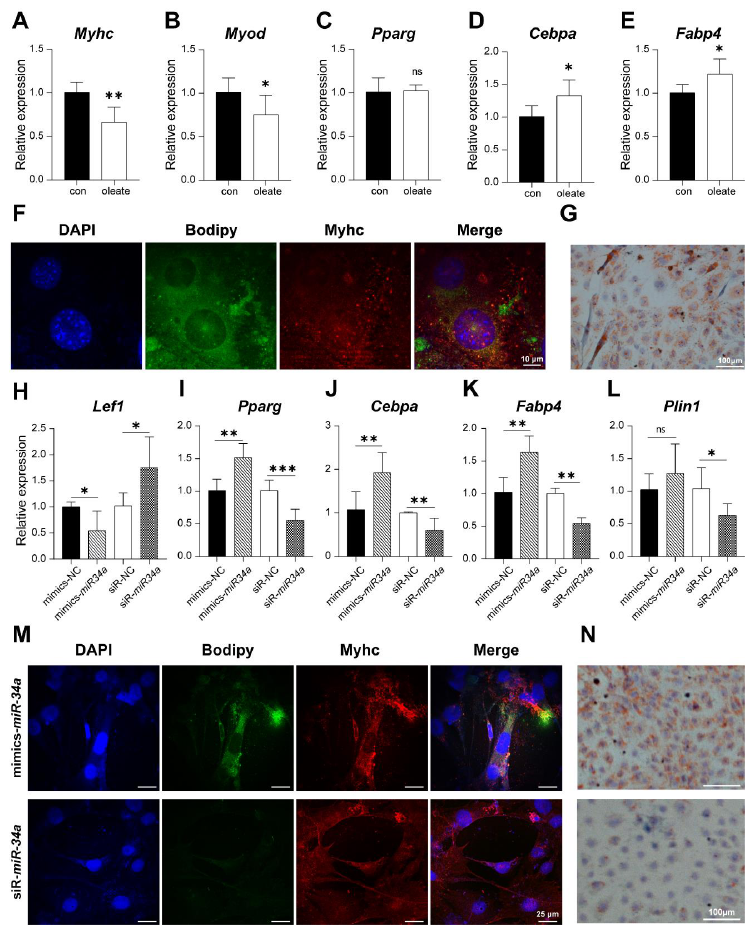
Figure 9. miR-34a positively regulates the expression of adipogenic genes in C2C12 cells. The ex- pression of MyHC ( A ), MyOD ( B ), Pparg ( C ), Cebpa ( D ), and Fabp4 ( E ), as well as immunofluores- cence ( F ) and Oil Red O staining ( G ) assays when C2C12 induced by oleate for 24 h ( n = 6). The expression of miR-34a ( H ), Lef1 ( I ), Pparg ( J ), Cebpa ( K ), Fabp4 ( L ), and Plin1 ( M ) ( n = 6) and the OD value (510 nm) of Oil Red O extraction (N, n = 3) and immunofluorescence (O) and Oil Red O stain- ing (P) when C2C12 cells were transfected with the miR-34a mimics, inhibitor, and their correspond- ing controls. The scale bar of immunofluorescence was 25 μm and the magnification was 4×. The qPCR data showed the means of six independent experiments and the data of OD value (510 nm) showed the means of three independent experiments. * p < 0.05, ** p < 0.01, *** p < 0.001 versus NC.